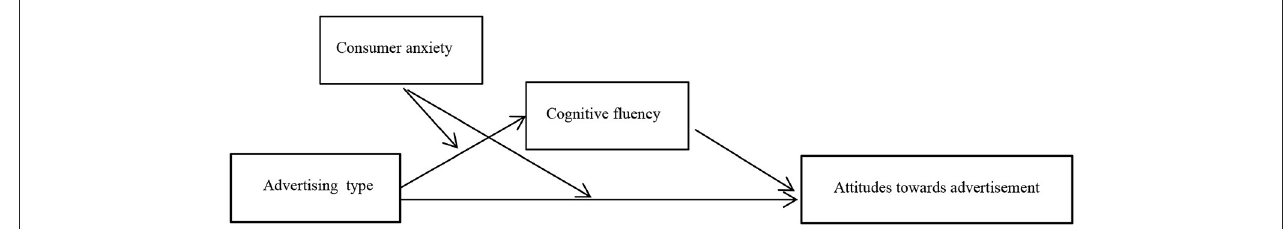
FIGURE 1 | The conceptual model of this